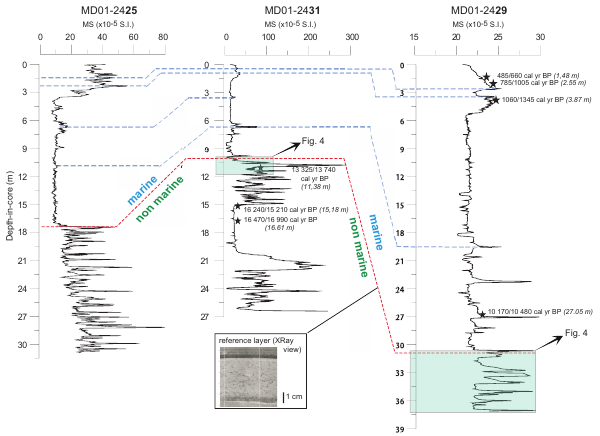
Figure 3. Chronostratigraphic correlations between the Çinarcik Basin (core MD01-2425) and the Central Basin (cores MD01-2429 and -2431). Blue rectangles correspond to close-up and detailed cor- relations in Fig.